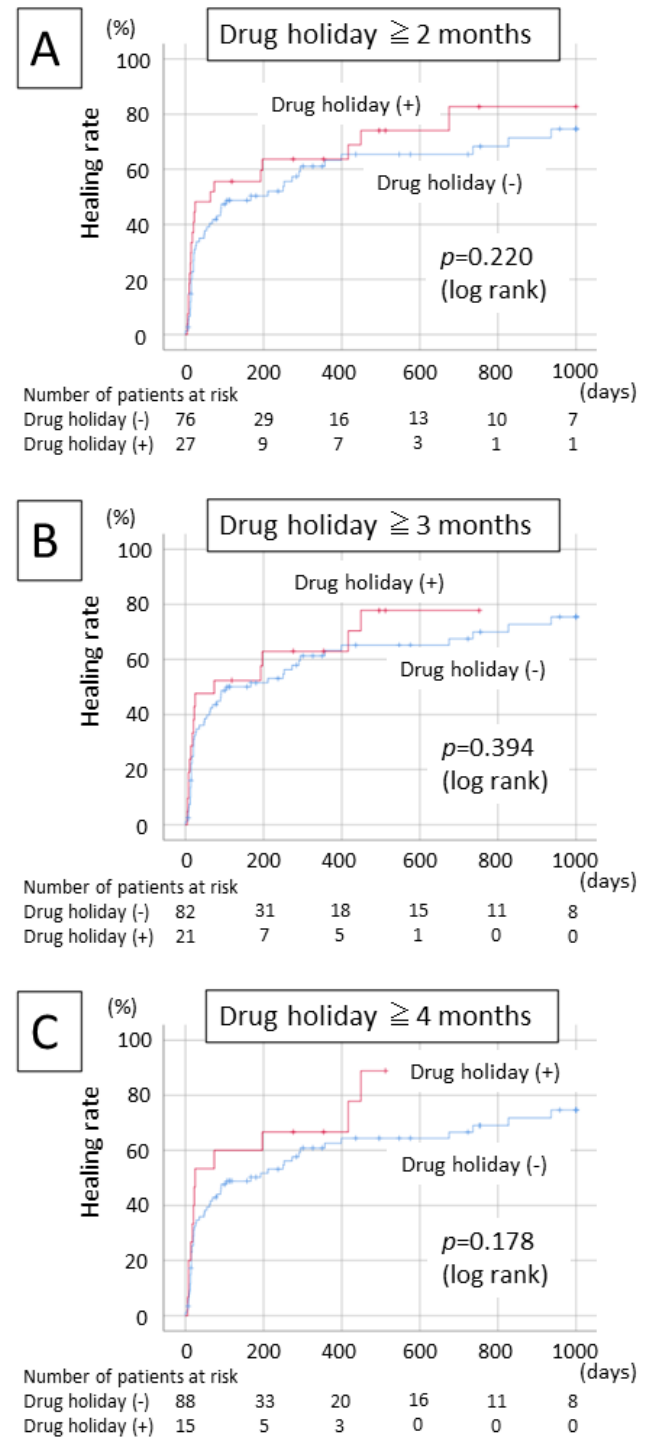
Figure 2. Healing rate by drug holiday; ( A ) drug holiday for 60 days; ( B ) drug holiday for 90 days; and ( C ) drug holiday for 120 days.